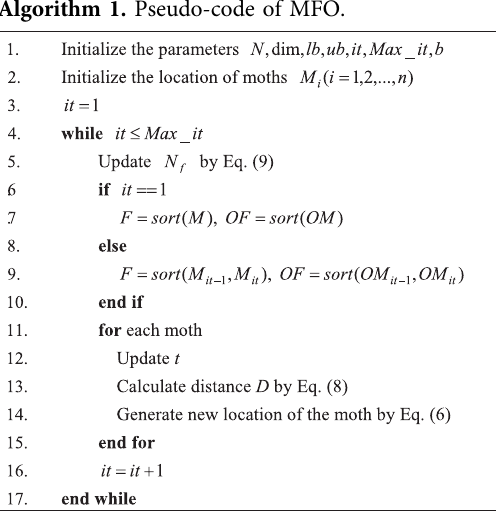
Algorithm 1. Pseudo-code of MFO.